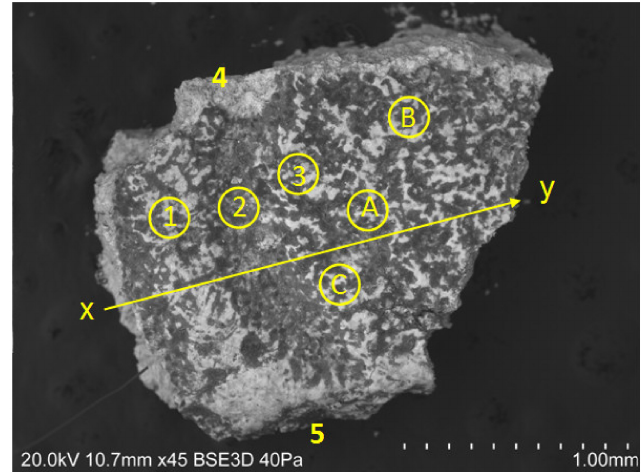
Figure 4. Piece of the selected ornamental layer samples (S2): photograph with analysis area positioning—BSE, SEM Image: 1, 2, 3, 4, 5, A, B, C – represent the areas of analysis.